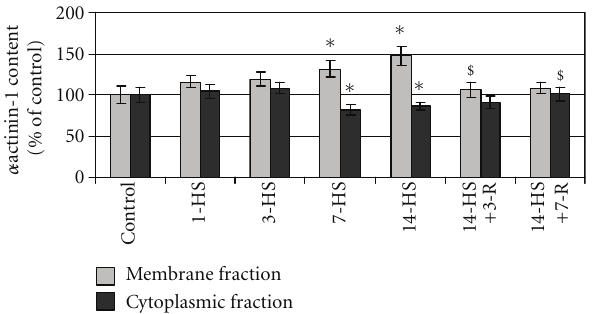
Figure 2: Beta-actin content in the rat’s left ventricular myocytes under gravitational unloading and subsequent reloading; n = 7 samples for each group; ∗ P < 0 . 05 as compared to the group “Control”, $ P < 0 . 05 as compared to the group “14-HS”.